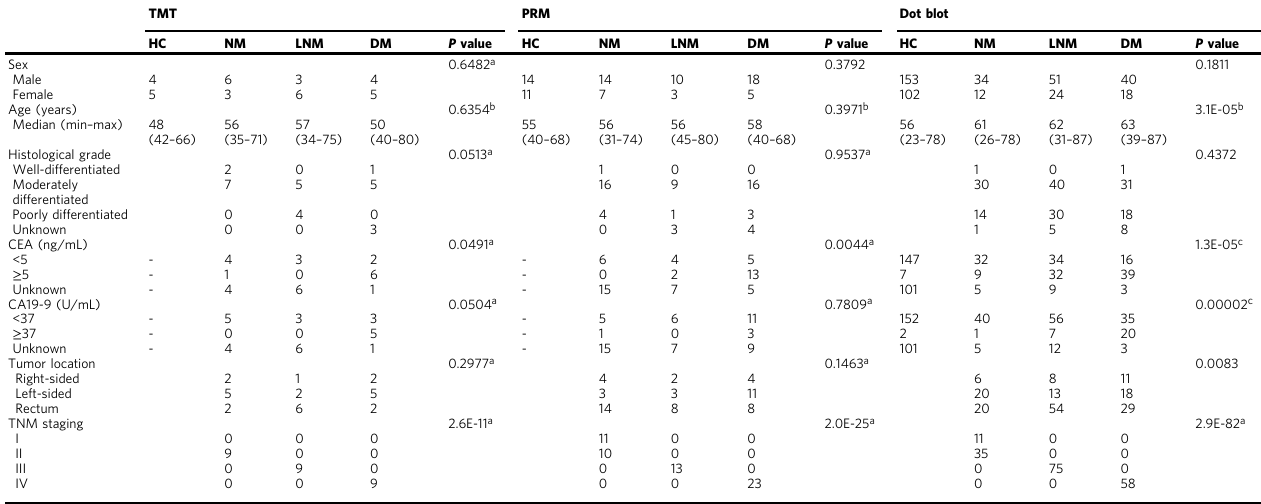
Table 1 Clinical information of all samples used in this